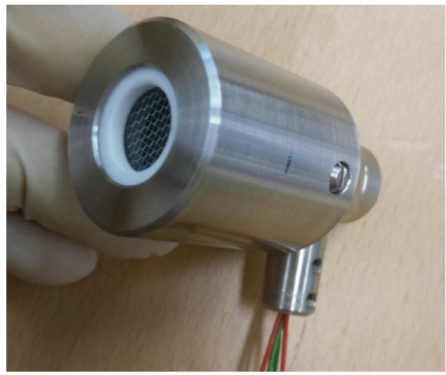
Figure 8. Retarding potential analyzer.